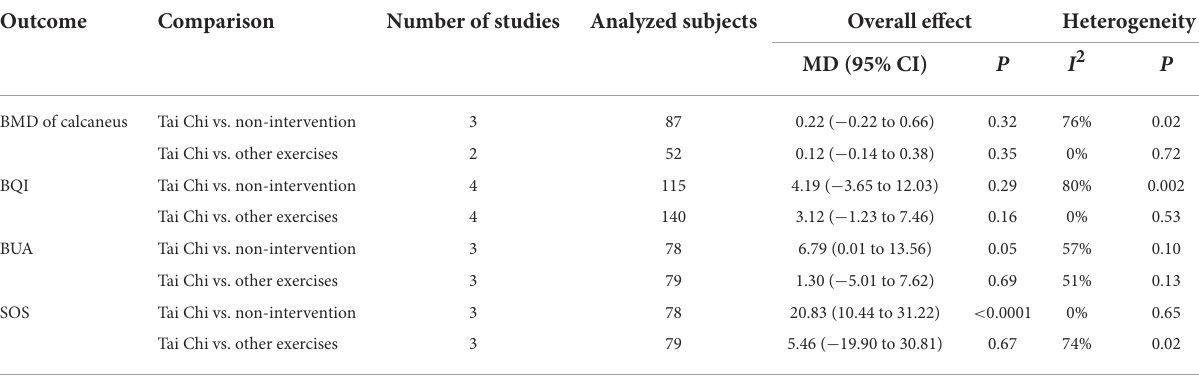
TABLE 2 The meta-analysis results for outcomes of calcaneus quantitative ultrasound. Outcome Comparison